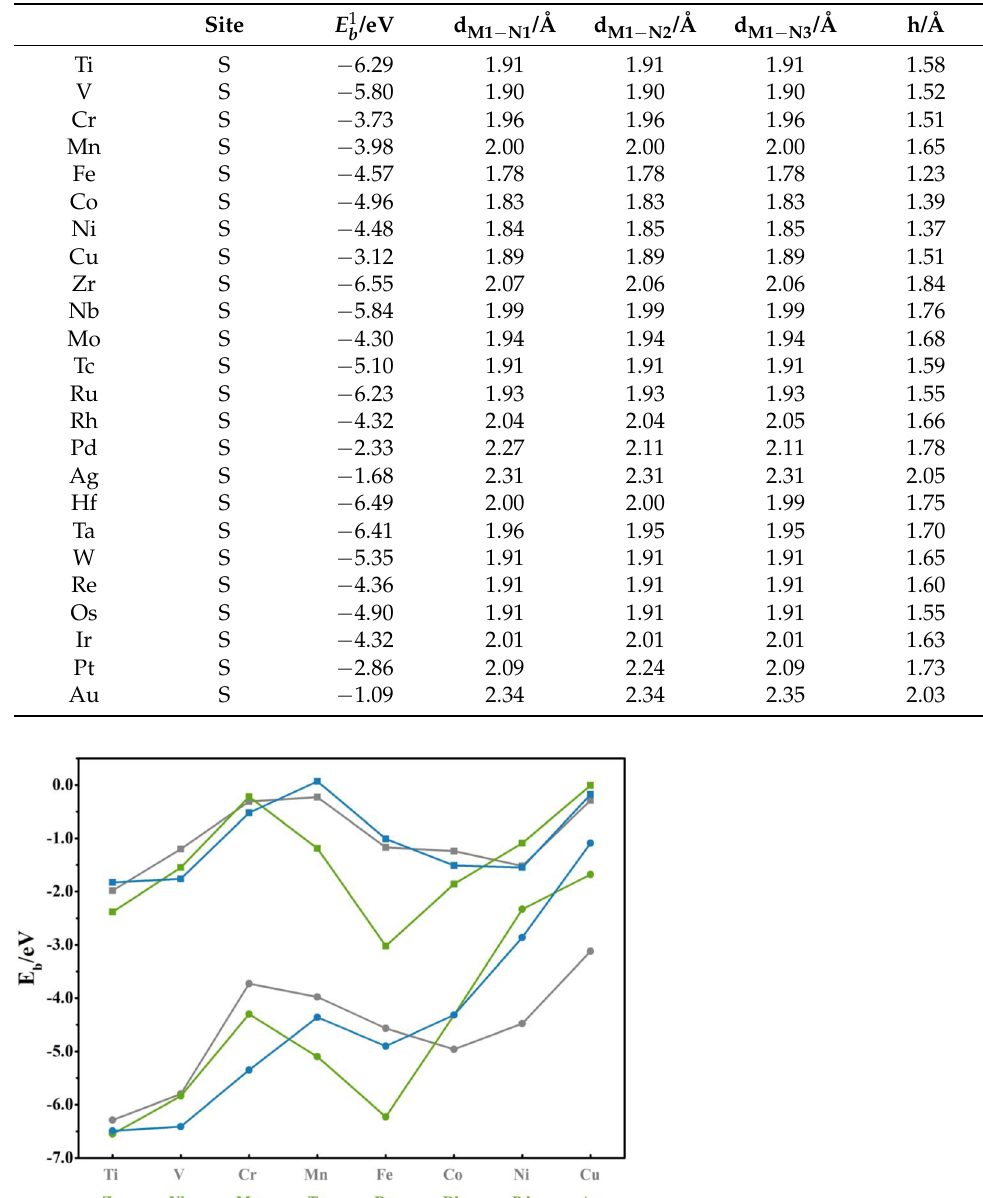
), the distance between the anchored b